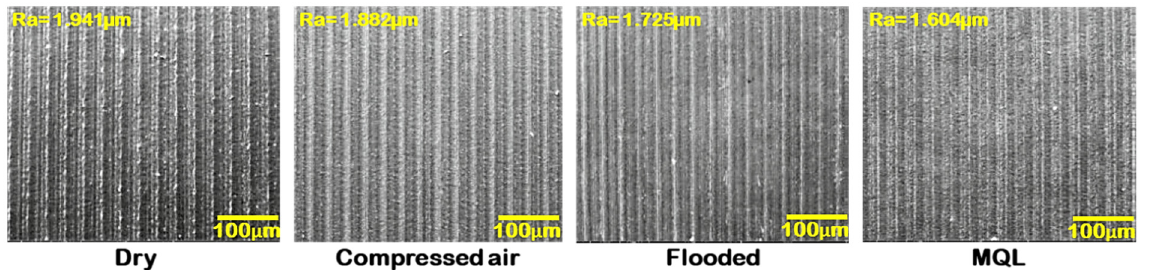
Figure 14. Optical images of machined surface under various cutting environments at v = 111 m/min, f = 0.20 mm/rev.